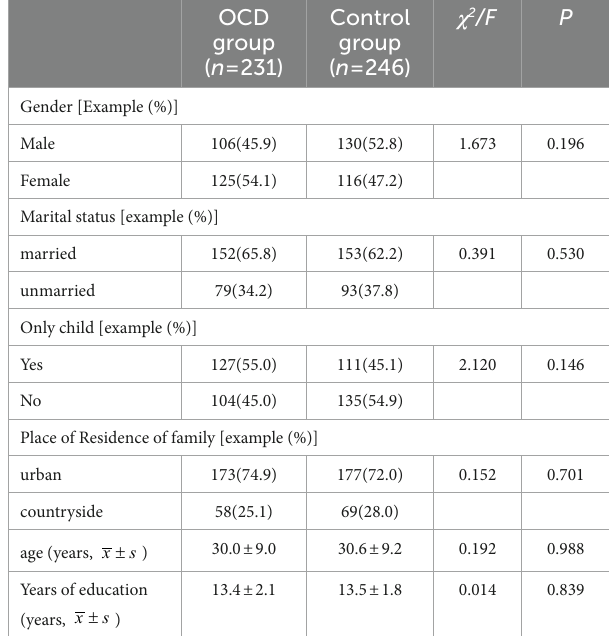
TABLE 1 Comparison of demographic data between the two